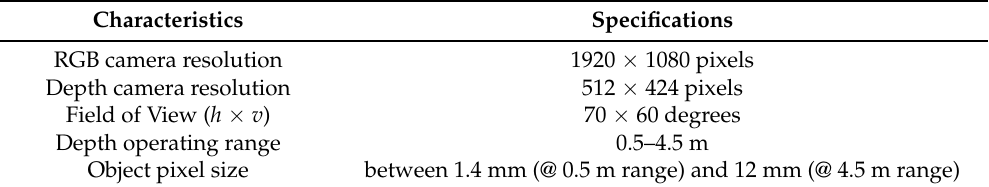
Table 1. Kinect V2 sensor characteristics and specifications. Data from [22].